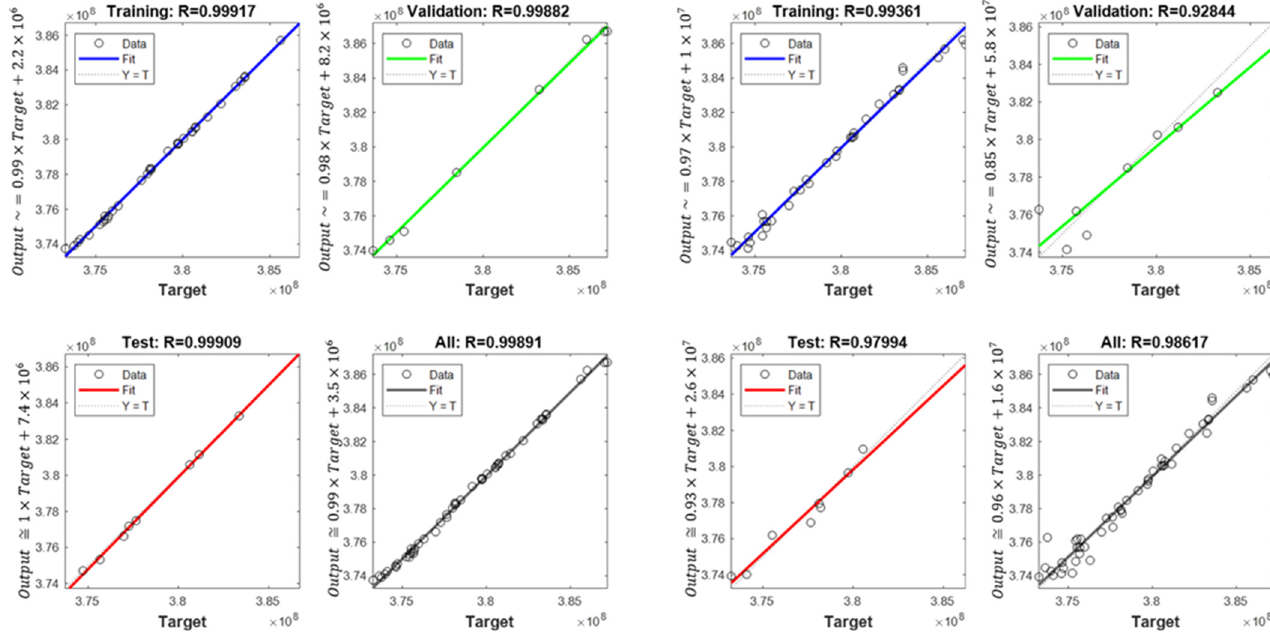
Figure 22. Matching the training data for the SCG algorithm (NN 20 - 2 - 1) on the left and RPROP algorithm (NN 20 - 3 - 1) on the right.